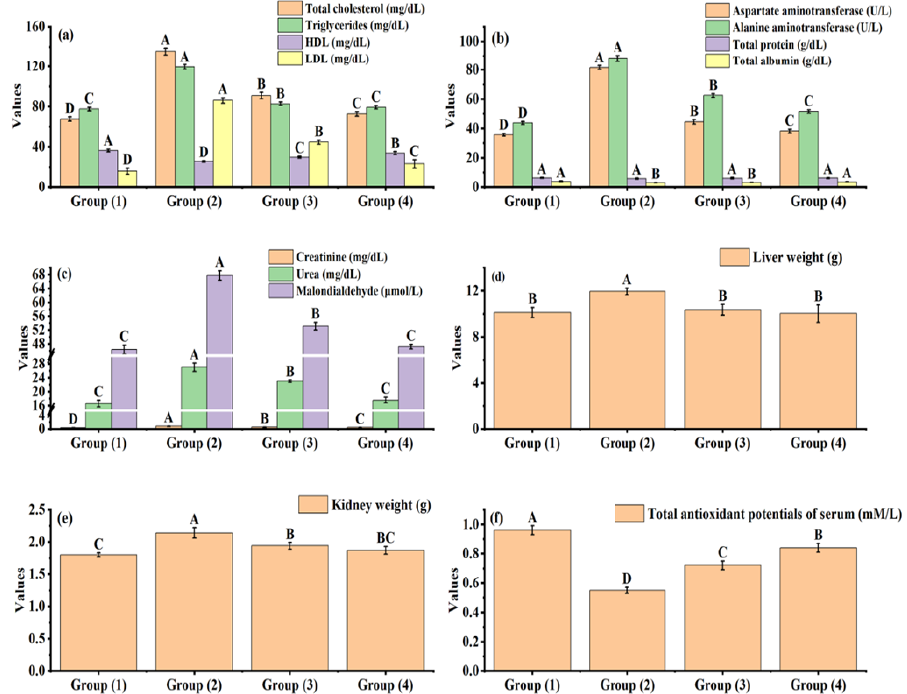
Figure 2. Effect of yogurt fortified with 0.4% aqueous Hawthorn leaf extract on serum: lipid profile ( a ), liver function parameters ( b ), kidney function parameters ( c ), liver weight ( d ), kidney weight ( e ), and total antioxidant potentials of serum ( f ) of the oxidative stress rats. Group (1) non-treated rats (negative control). Group (2) treated oxidative stress rats (positive control). Group (3) oxidative stress rats fed a basal diet with plain yogurt (10g/day). Group (4) oxidative stress rats fed on basal diet with yogurt fortified with 0.4% aqueous Hawthorn leaf extract (10g/day). Values with different superscript letters are significantly different at ( p ≤ 0.05). Mean values ± standard deviation.